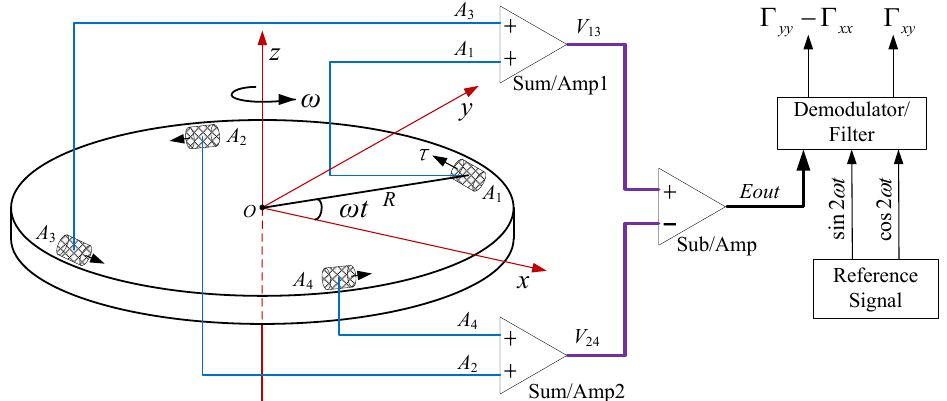
Figure 1. Working principle schematic diagram for the rotating accelerometer gravity gradiometer